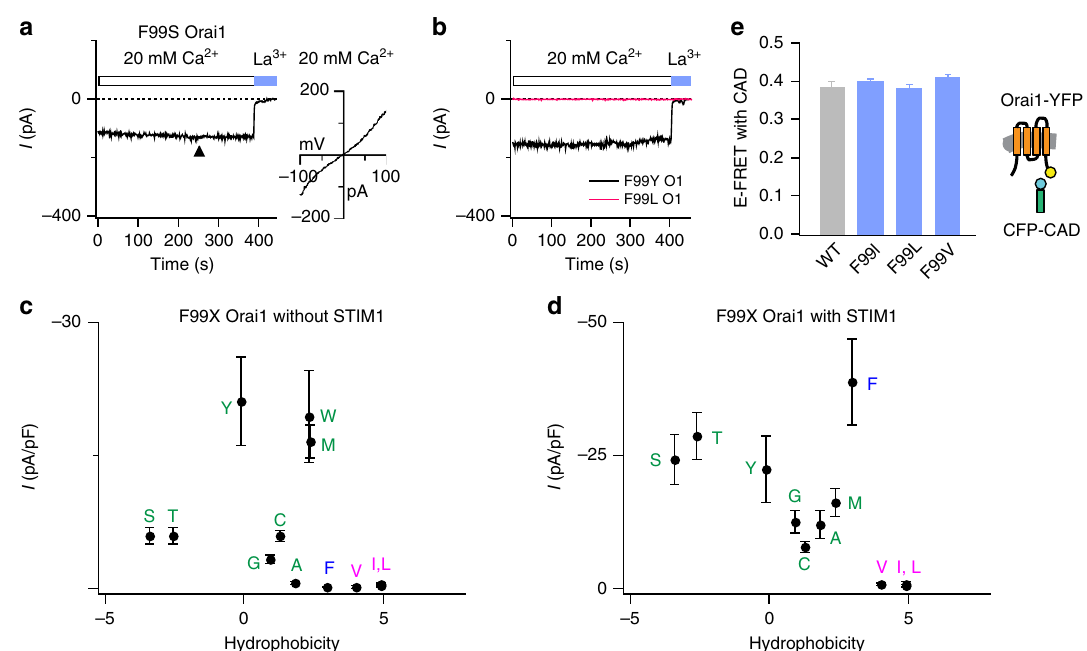
Figure 4 | Mutations at F99 produce constitutively permeant Orai1 channels. ( a , b ) Time-course of Orai1 current in cells expressing the F99S, F99Y or F99L mutants after whole-cell break-in. Time zero represents the moment of whole-cell break-in. Orai1 mutants were expressed in HEK293 cells without STIM1. The current–voltage relationship of F99S Orai1 at the time point indicated by the arrowhead is shown in the right graph of a . ( c , d ) Mutational analysis of F99. The current densities measured at steady-state following whole-cell break-in (300–500 s) are plotted against the solvation energies 38 (kcalmol (cid:2) 1 ) of the substituted amino acid as a measure of their hydrophobicity in the absence ( c ) or presence ( d ) of STIM1 co-expression. Amino acid hydrophobicity increases from left to right. Values are mean ± s.e.m. The native residue (Phe) is shown in blue, the constitutively conducting mutants in green, and the non-conducting mutants in magenta. N ¼ 4–6 cells for each mutant. ( e ) FRET between the indicated Orai1-YFP constructs and CFP–CAD, showing that the mutations do not affect coupling of Orai1 to STIM1. No significant difference was seen in the different mutants compared with WT Orai1. N ¼ 32–36 cells for each mutant. Values are mean ±